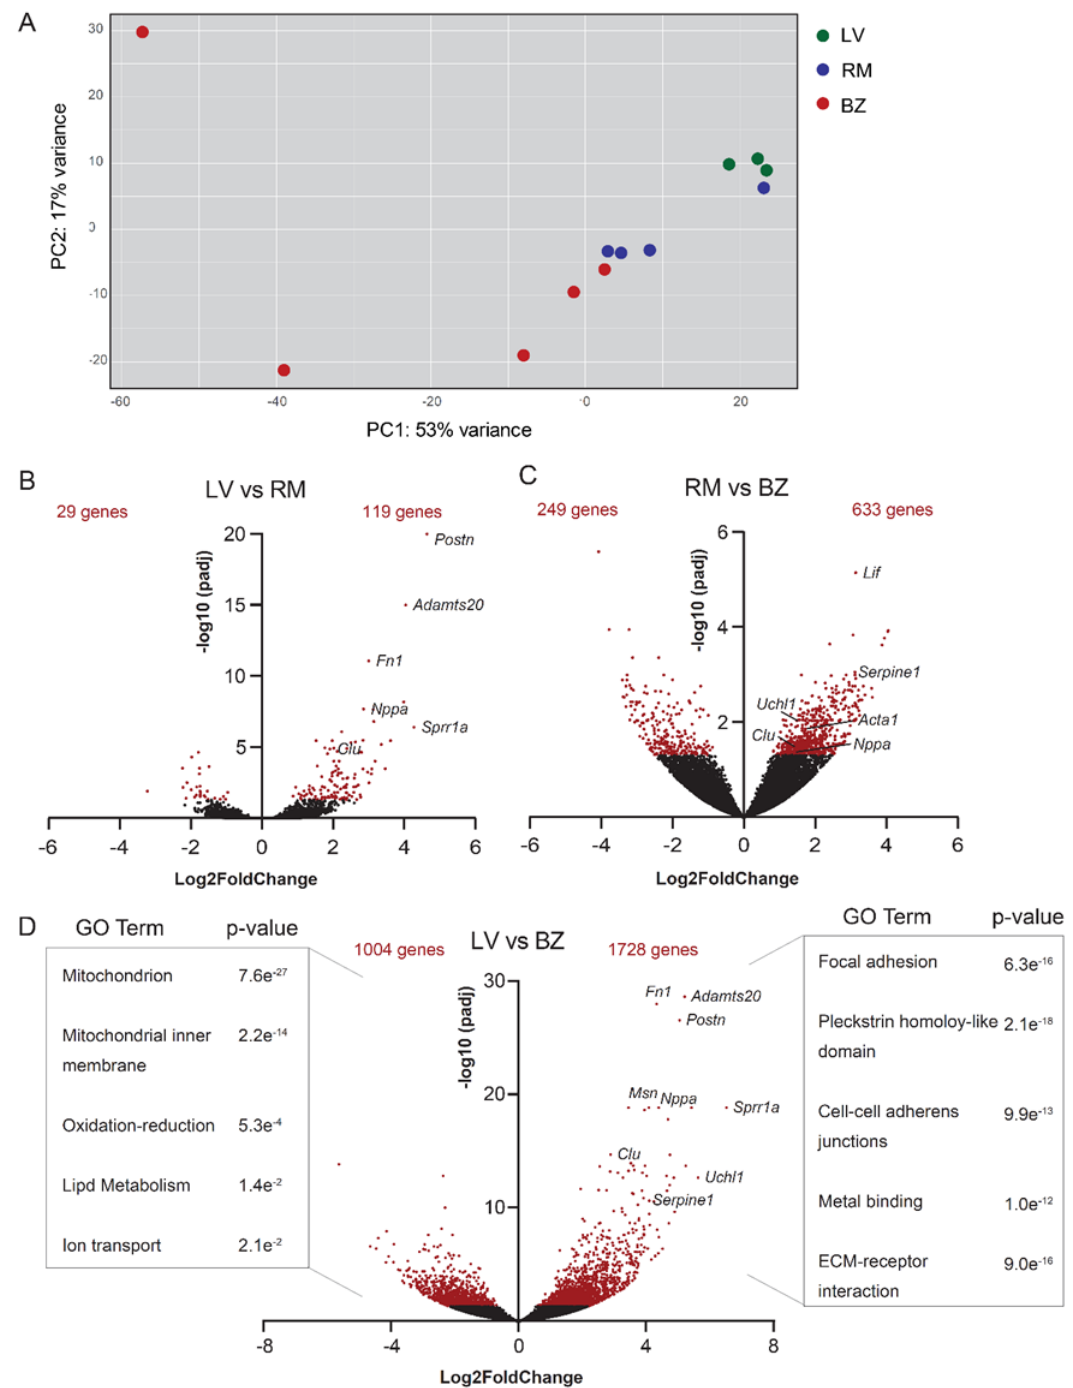
Figure 1. ( A ) Principal component analysis shows that samples from the left ventricle (LV) ( n = 3) cluster together. Border zone (BZ) ( n = 5) samples partially cluster with samples from the remote myocardium (RM) ( n = 4) or do not cluster together. Green: LV, red: BZ, blue: RM. ( B ) Volcano plots showing nuclear transcripts of PCM1-positive cardiomyocytes that are differentially expressed between LV and RM and ( C ) RM and BZ. ( D ) Volcano plots showing nuclear transcripts of PCM1-positive cardiomyocytes that are differentially expressed between RM ( n = 4) and BZ ( n = 5). Red dots show significantly differentially expressed genes ( p adjusted for multiple testing: false discovery date < 0.05). ( D ) Volcano plot shows significantly differentially expressed genes between BZ ( n = 5) and LV ( n = 3). Gene ontology analysis was performed on significantly higher and lower expressed genes of both groups.